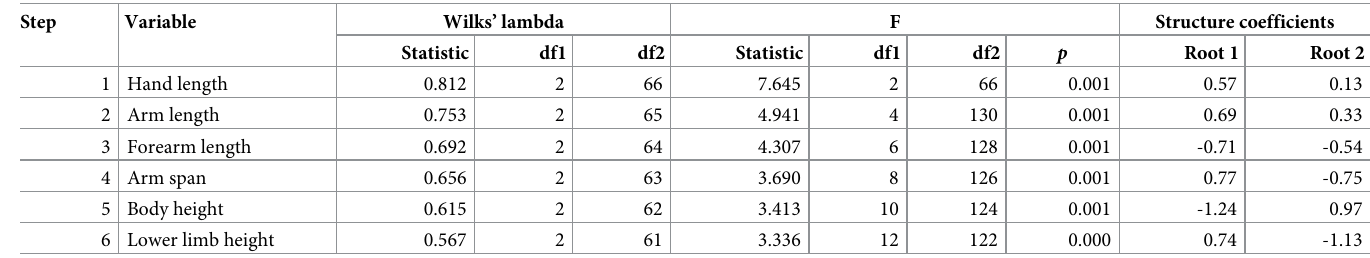
Table 3. Summary of stepwise discriminant analysis by